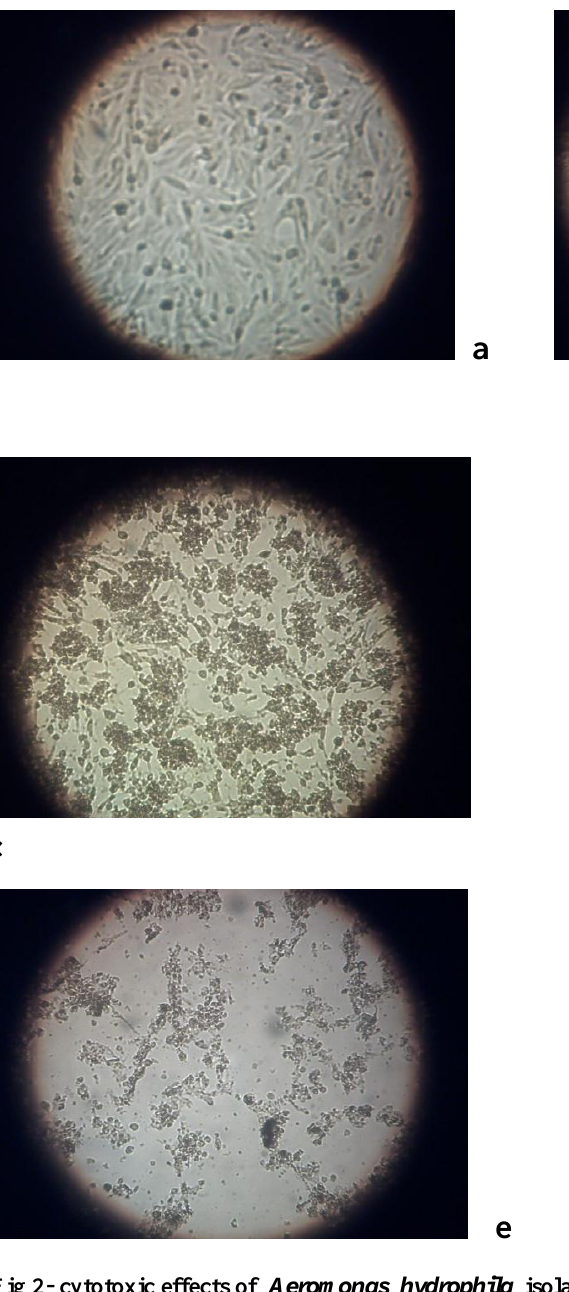
Fig 2- cytotoxic effects of Aeromonas hydrophila isolates on Vero cell line. ( a = Control Vero cell b, c, d = represent the progression of cytotoxic effects on Vero cell manifested by the clusters of rounding cells and cell shrinkage e) complete cell detachment that appears with in 12 hours for the isolates that give the titer of 1:16